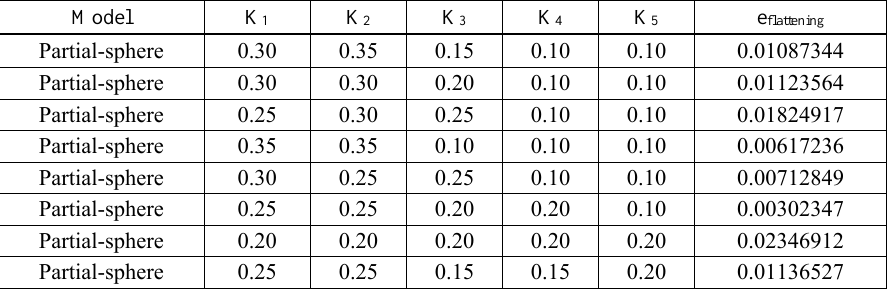
Table 1. The related parameters determination